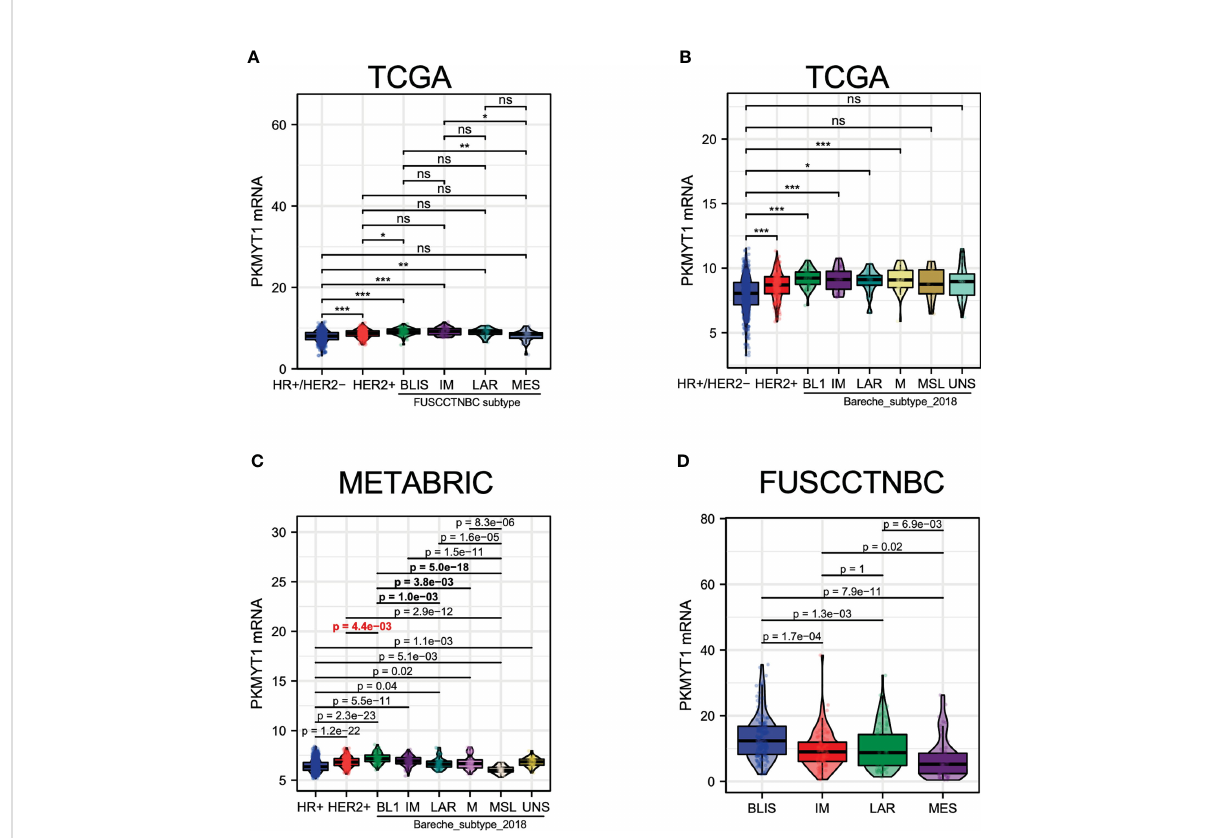
FIGURE 7 The PKMYT1 mRNA expression levels in different molecular types of TNBC. (A) The analysis for PKMYT1 expression in “ Fudan classi fi cation “ and other molecular types of BC in the TCGA cohort. (B) The analysis for PKMYT1 expression in TNBC “ Bareche classi fi cation ” and other molecular types in the TCGA cohort. (C) METABRIC dataset analysis of PKMYT1 expression in TNBC “ Bareche classi fi cation ” and other molecular types. (D) The analysis for PKMYT1 expression in different TNBC molecular types in the FUSCCTNBC cohort. * p < 0.05, ** p < 0.01, *** p < 0.001. ns, no signi fi